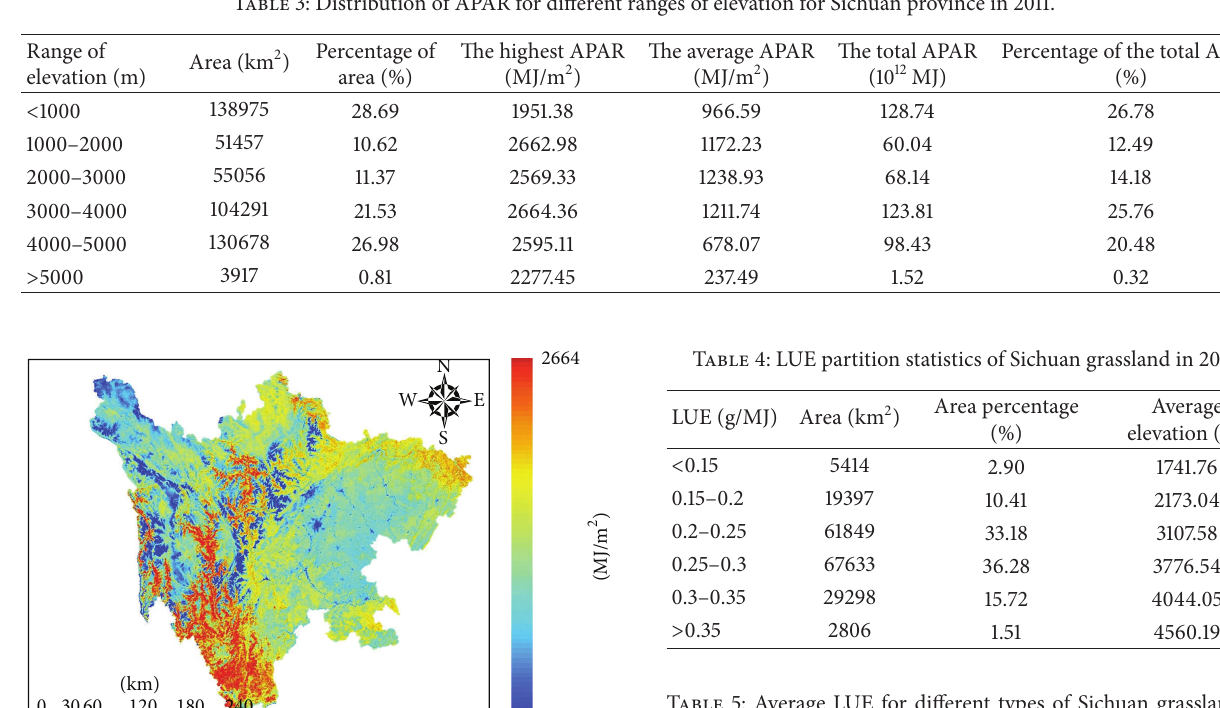
Table 5: Average LUE for different types of Sichuan grassland